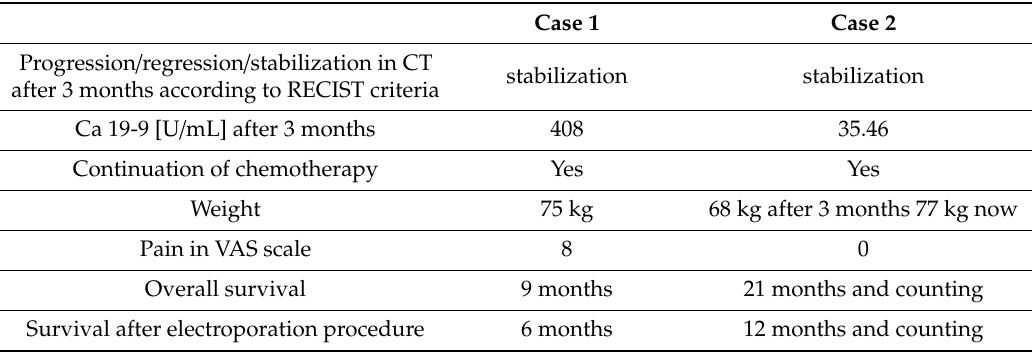
Table 3. Patient comparison 3 months post